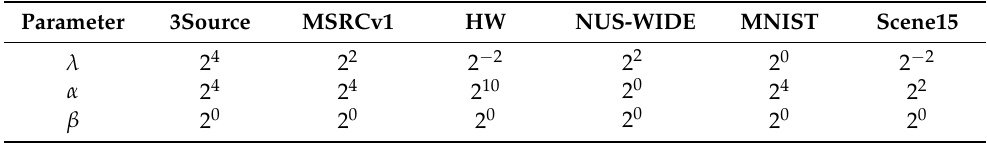
Table 2. The optimal values of the three